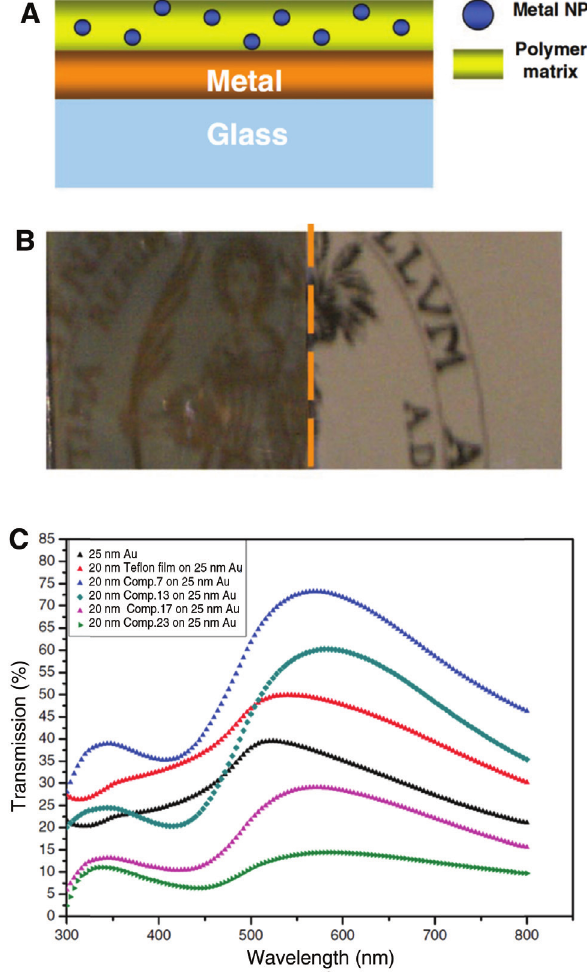
Figure 22: (A) Geometry of the sample studied by Elbahri and cow- orkers [53]. The structure is composed of glass coated with a thin (25 nm) gold film and a polymer containing silver nanoparticles. (B) Photograph of the Christian-Albrechts University logo taken through a glass piece coated with a 25 nm gold film (left) and 20 nm Comp.7 on a 25-nm gold fi lm (right). Comp. 7 means the nanocomposite sample with 7 wt% of gold nanoparticles. (C) Transmission spectra for the sample arrangement shown in (A) with 7 vol%, 13 vol%, 17 vol%, and 23 vol% filling factors of the nanocomposite layer. The uncoated 25 nm gold film and the 20 nm Teflon film coated on a 25 nm gold film are shown as references. Reprinted with permission from Adv. Mater., vol. 23, pp. 1993–1997, 2011. Copyright 2011 John Wiley and